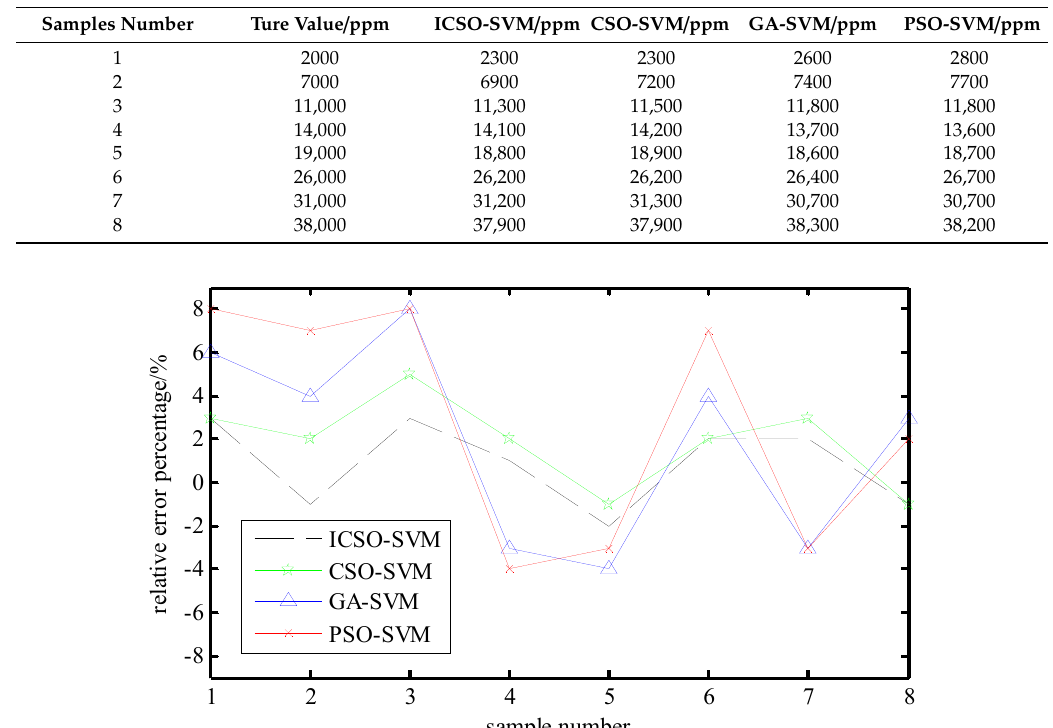
Table 4. The recovery rates and the mean squared errors of four models.